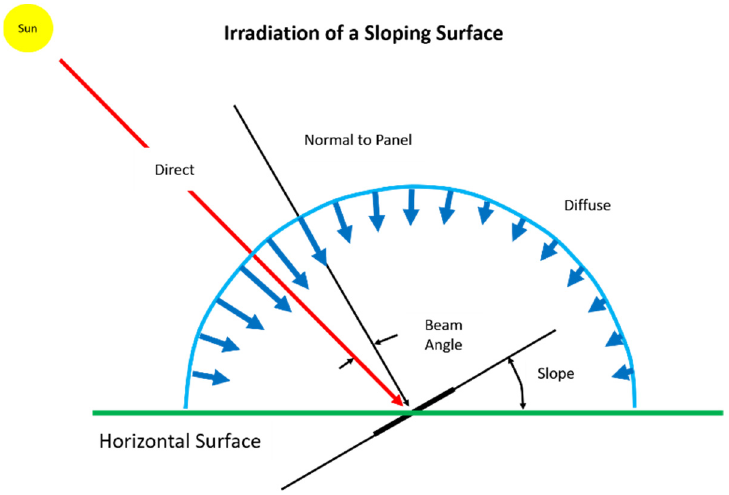
Figure 6. Geometry for estimating solar irradiance on a PV panel (adapted from Figure 1, [27]). The solar energy generated by the PV panels required the incident beam angle as shown above in Figure 6. This was calculated as: